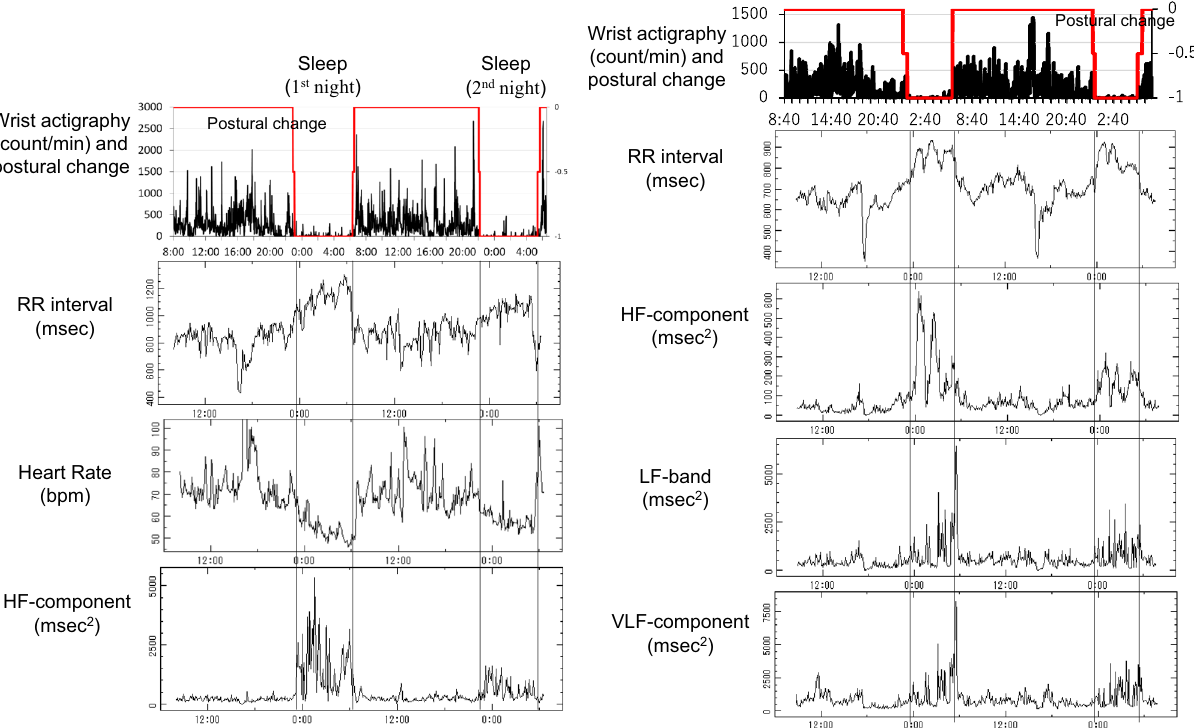
Figure 1. Estimation of sleep span (left) and assessment of sleep quality (right). Left: Sleep span is estimated by wrist activity data with postural change (row 1), RR-intervals (row 2), heart rate (row 3), and changes in the HF-component (row 4). This example shows day-to-day differences in the sleep-related increase in the HF-component of HRV. The spectral power of the HF-component is higher on the first day (row 4). In addition, the nocturnal HR dip is blunted on the second day as compared to the first day (row 3). Right: Representative example of a 48-h concomitant record of wrist activity, RR-intervals, and HF-component, LF-band and VLF- component of HRV. Right and left results are from different astronauts. Sleep quality is assessed by determining whether there is a sleep-related (1) decrease in activity (row 1); and increase during the sleep span in (2) RR-intervals (row 2); (3) power in the HF-component (row 3); (4) power of the LF-band (row 4); and (5) power of the VLF-component (row 5). A sleep quality score is obtained by summing the 5 items for each night, on a scale of 0 to 10 points (Yes/No is